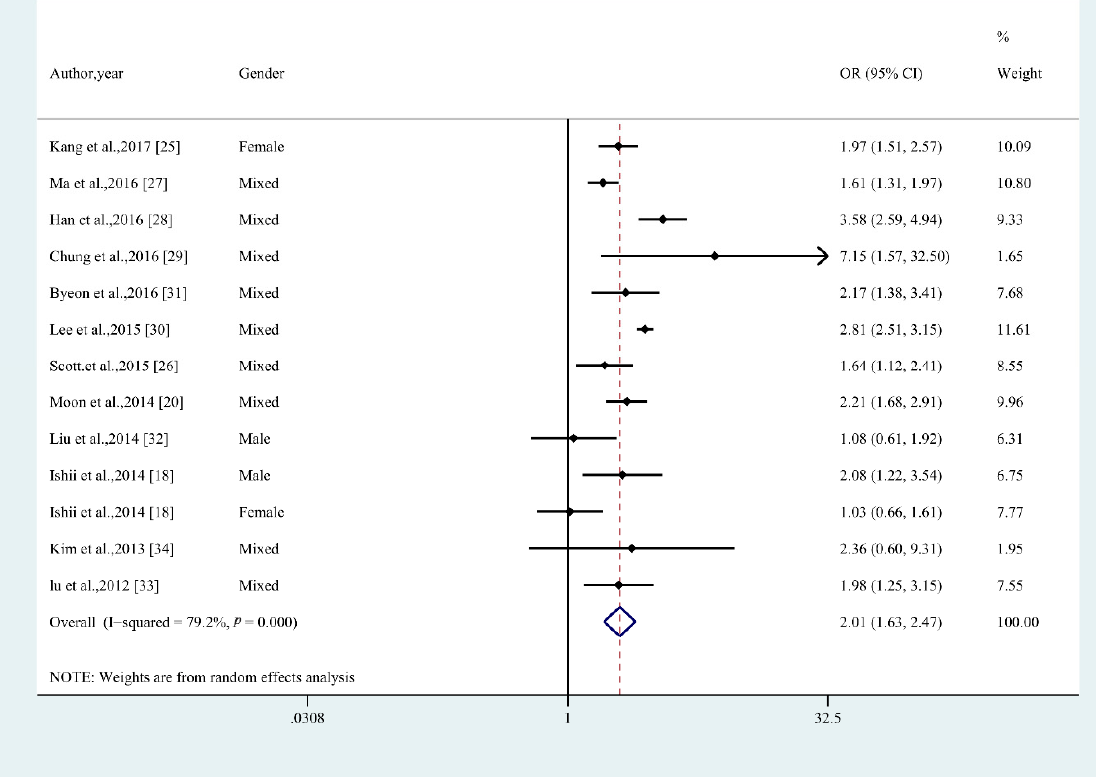
Figure 3. Funnel plot with pseudo 95% con fi dence limits for the association between MetS and sarcopenia in middle ‐ aged and older non ‐ obese adults. OR, odd ratios; CI, con fi dence interval.